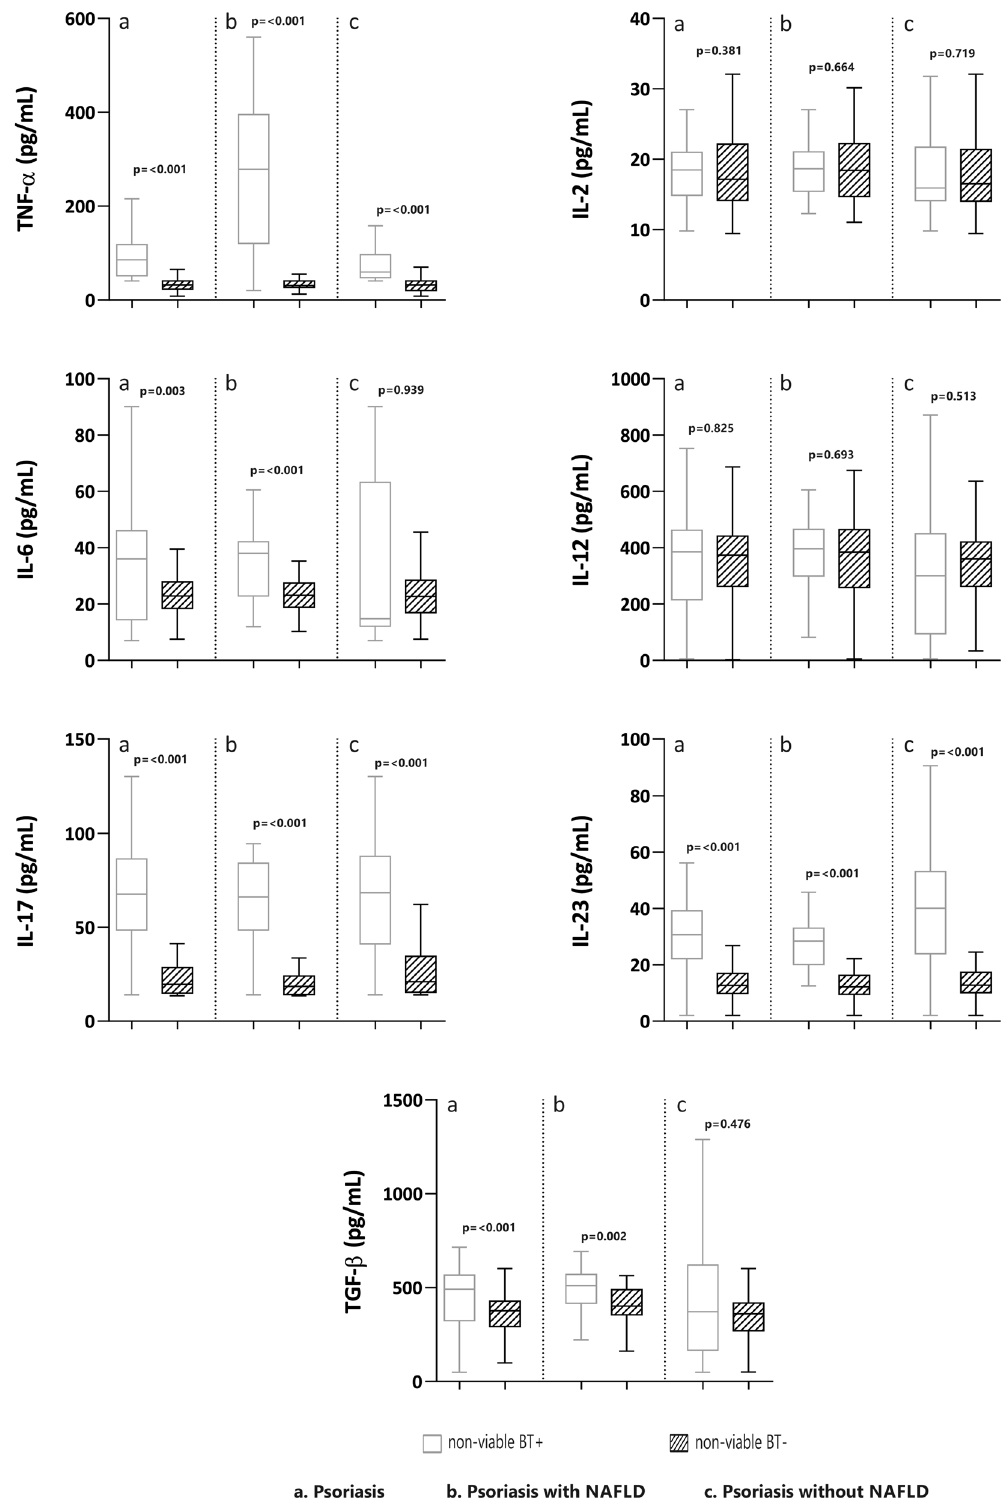
Figure 3. Cytokine values in participants with and without non-alcoholic fatty liver disease (NAFLD), according to bacterial translocation